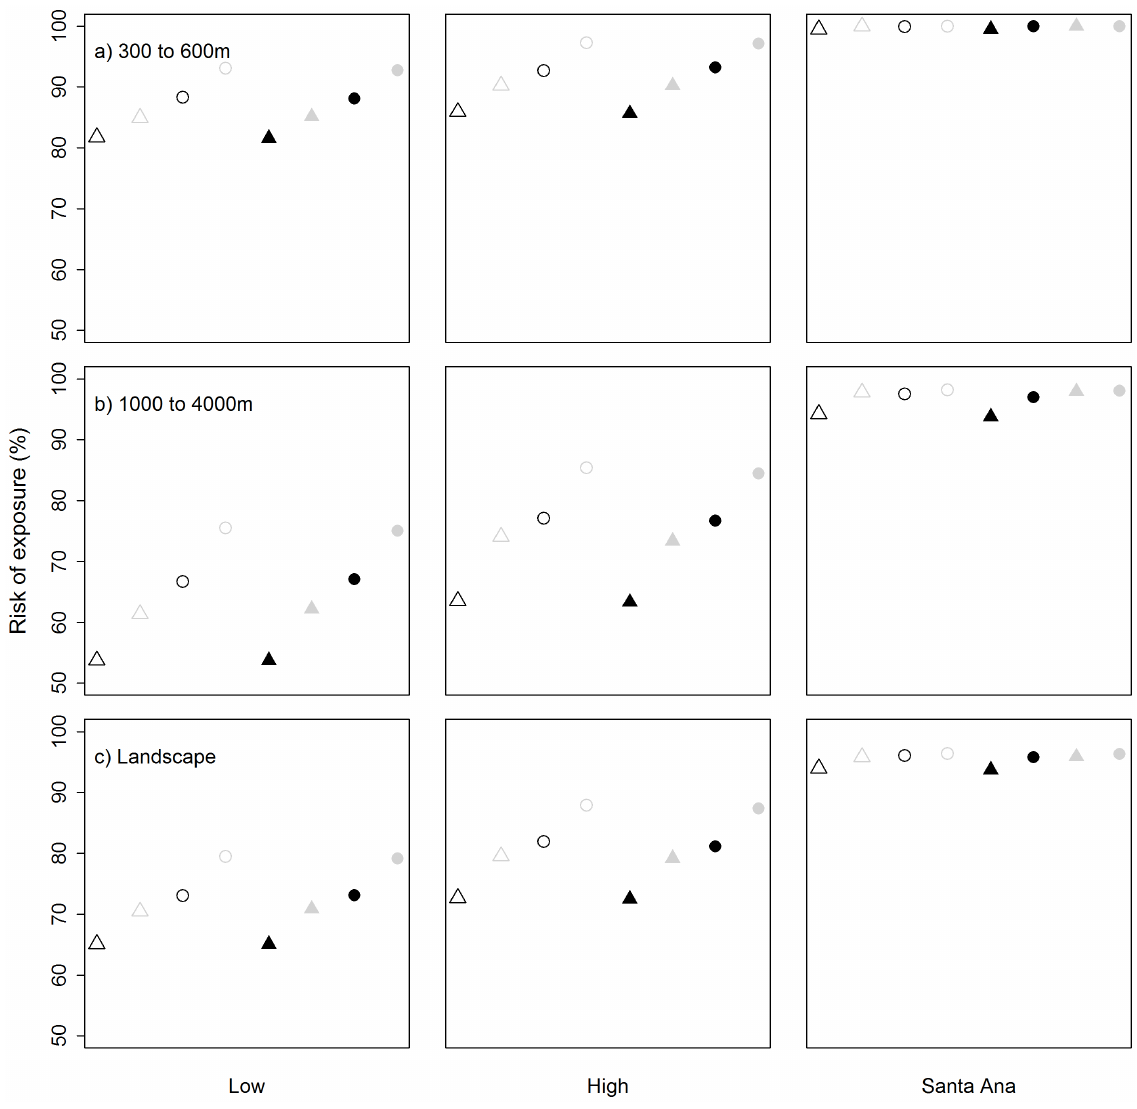
Figure 4. Risk of exposure for the 24 scenarios modelled for a) fires igniting at elevations of 300 to 600 m; b) fires igniting at elevations of 1000 to 4000 m; c) all locations across the landscape. Open symbols=fuel break scenarios; closed symbols=no fuel breaks; Grey symbols=fuel moisture of 60%; Black symbols=fuel moisture of 90%; Circles=high landscape fuel loads; Triangle=low landscape fuel loads.